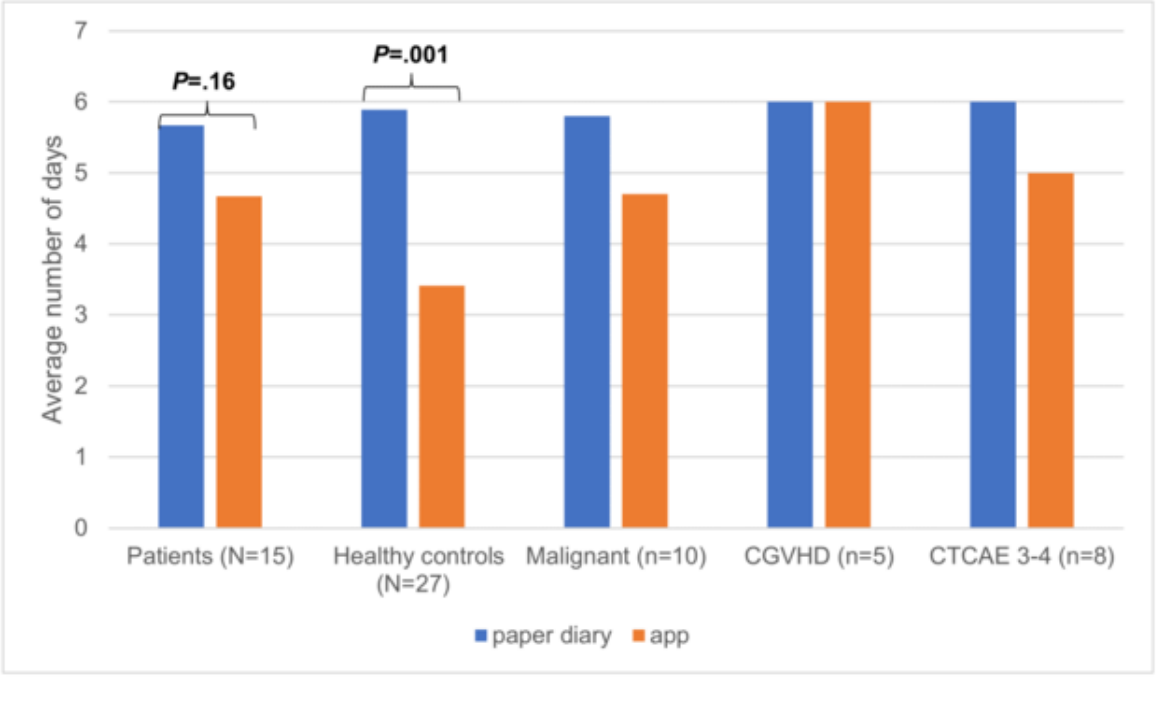
Figure 4. Comparison of the paper diary versus mobile app: duration in days of data entry. Malignant refers to malignant underlying disease. cGVHD: chronic graft-versus-host disease; CTCAE 3-4: National Cancer Institute (NCI) Common Terminology Criteria for Adverse Events (CTCAE) grade of 3-4.